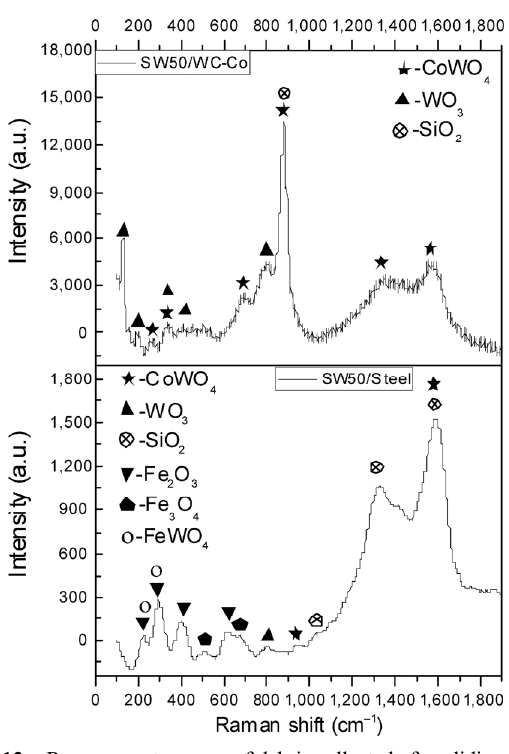
Fig. 13 Raman spectroscopy of debris collected after sliding wear of SW50 composites against WC-Co and steel counterbodies.